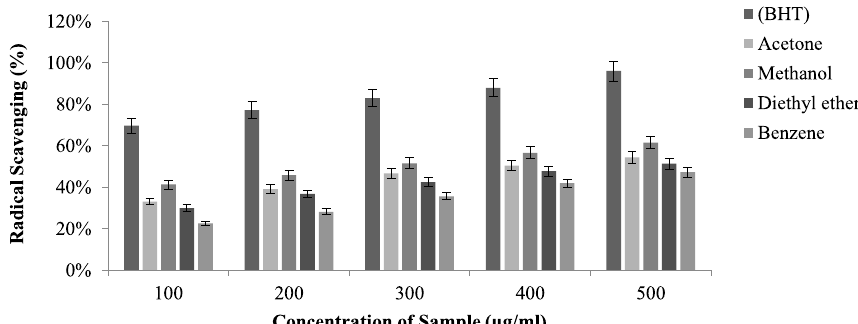
Fig. 6 DPPH radical scavenging activity of T. virens in various solvent extractions